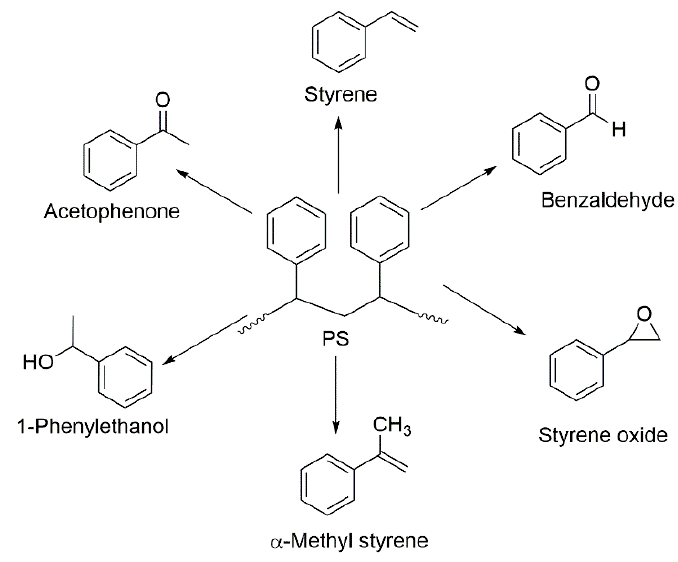
Figure 4. Thermal degradation products generated by burning polystyrene (PS) [36,38–42].